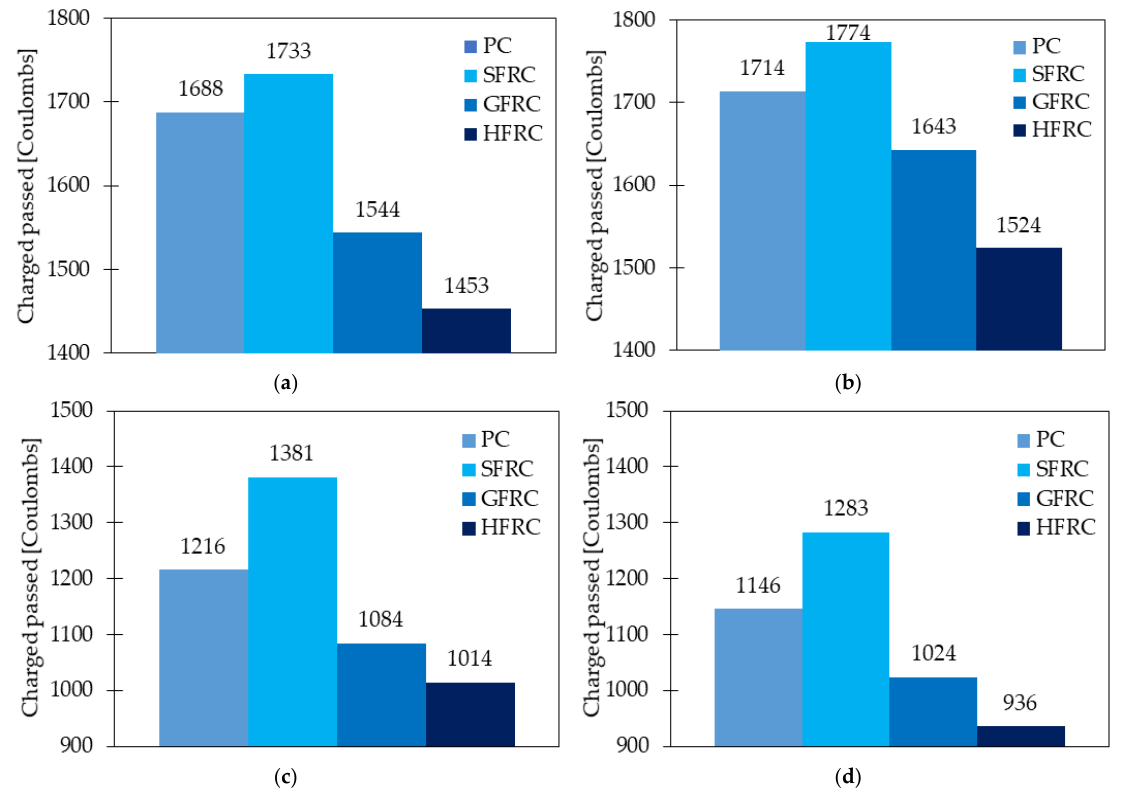
Figure 27. Chloride penetration test coefficients: ( a ) mix type 1—concrete grade 40 and sand to aggregate ratio 0.50; ( b ) mix type 2—concrete grade 40 and sand to aggregate ratio 0.57; ( c ) mix type 3—concrete grade 80 and sand to aggregate ratio 0.50; ( d ) mix type 4—concrete grade 80 and sand to aggregate ratio 0.57 [21].